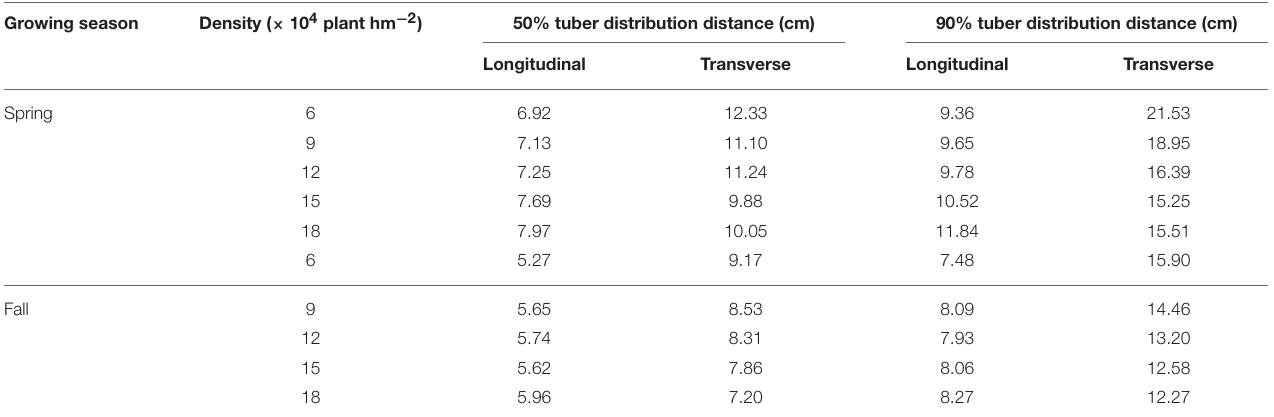
TABLE 7 | Potato tuber distribution distance of 50 and 90% at each plant density in the two growing seasons. Growing